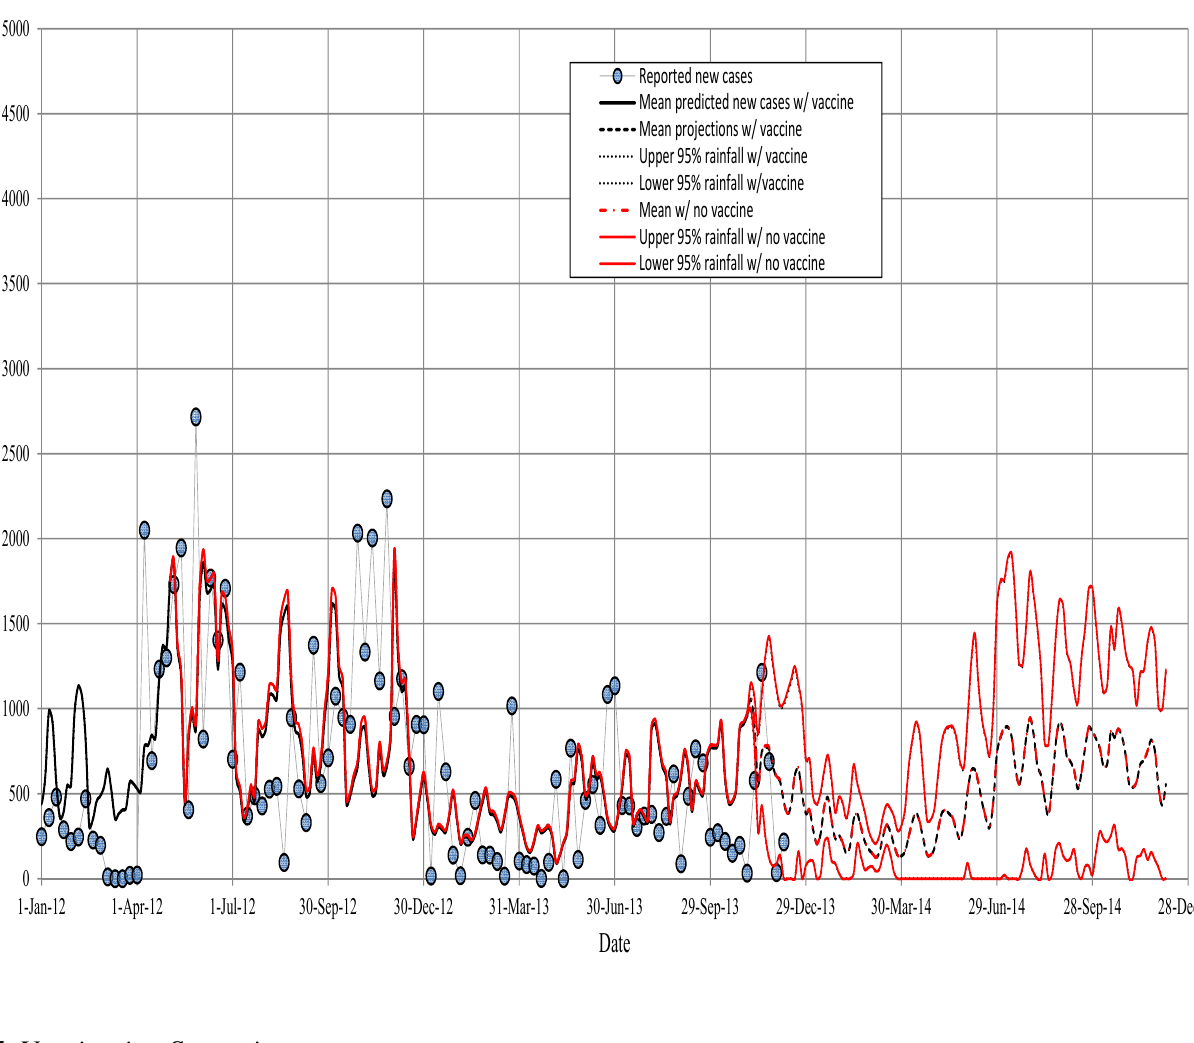
Figure 11. Ouest. The projected new symptomatic individuals vs . time. Circles, observed; solid line, model prediction; dashed lines, fifth, 50th and 95th percentiles for model projections based on the past 13 years of precipitation records. Projected and Reported Number of New Cases per Week vs Time Ouest (1 January 2012 to 7 December